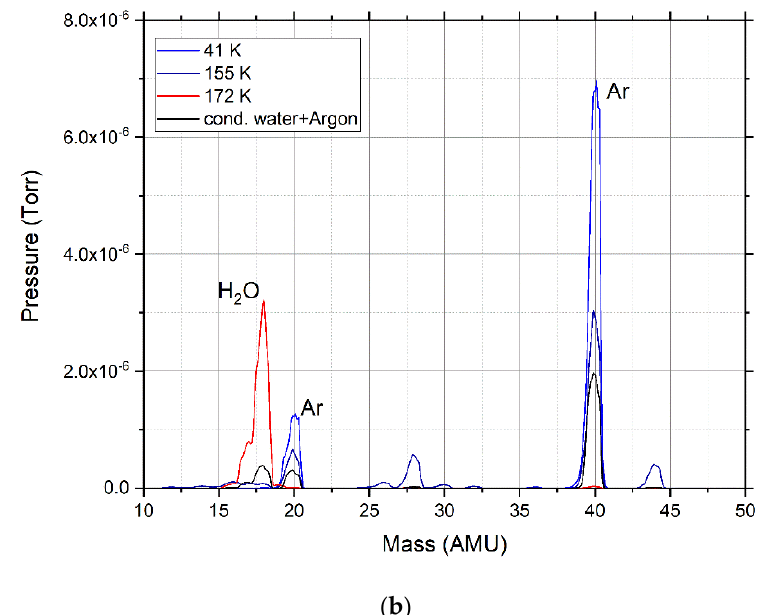
Figure 2. Mass spectra of condensation mixtures: ( a ) water and nitrogen; ( b ) water and argon.